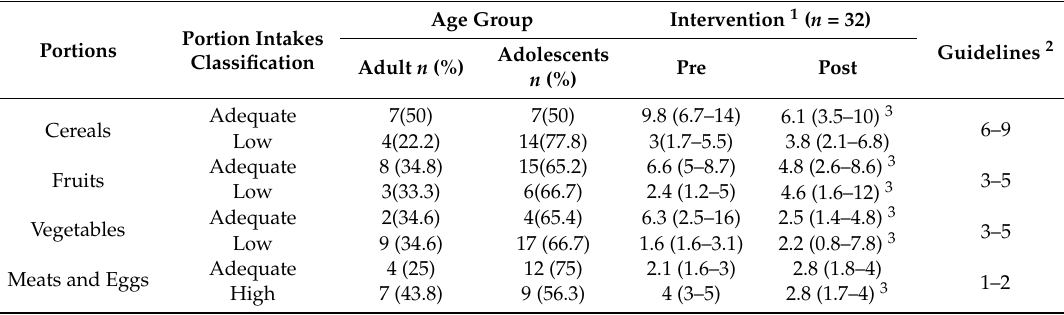
Table 3. Intake of food portions before and after the